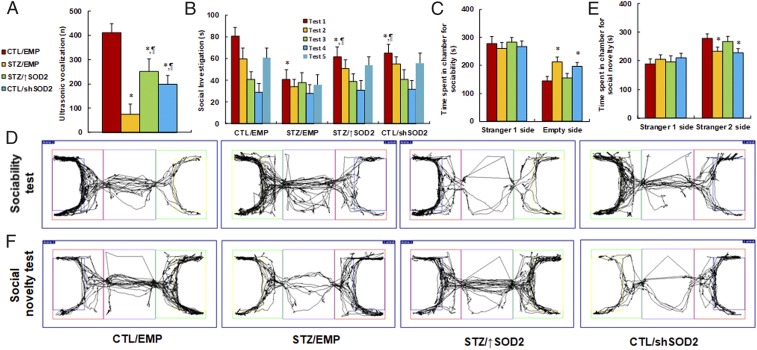
Maternal diabetes induces autism-like behavior in offspring, while SOD2 overexpression restores, and SOD2 knockdown mimics, this effect. The 6-wk-old male offspring from either the control (CTL) or maternal diabetes (STZ) groups received empty control (EMP), SOD2 overexpression (↑SOD2), or SOD2 knockdown (shERβ) lentivirus infusion, and then the offspring at 8 wk of age were used for autism-like behavior analysis. (A) Ultrasonic vocalization (n = 9). (B) Social recognition: seconds socially investigating a conspecific [same conspecific in tests 1 to 4; novel conspecific in test 5 (a new stimulus rat was introduced), n = 9; *P < 0.05 vs. CTL/EMP group; ¶P < 0.05 vs. STZ/EMP group]. (C–F) Three-chambered social tests (n = 8). (C) Time spent in chamber for sociability. (D) Representative trace recorder for C. (E) Time spent in chamber for social novelty. (F) Representative trace recorder for E (*P < 0.05 vs. CTL/EMP group; ¶P < 0.05 vs. STZ/EMP group). Data are expressed as mean ± SEM.